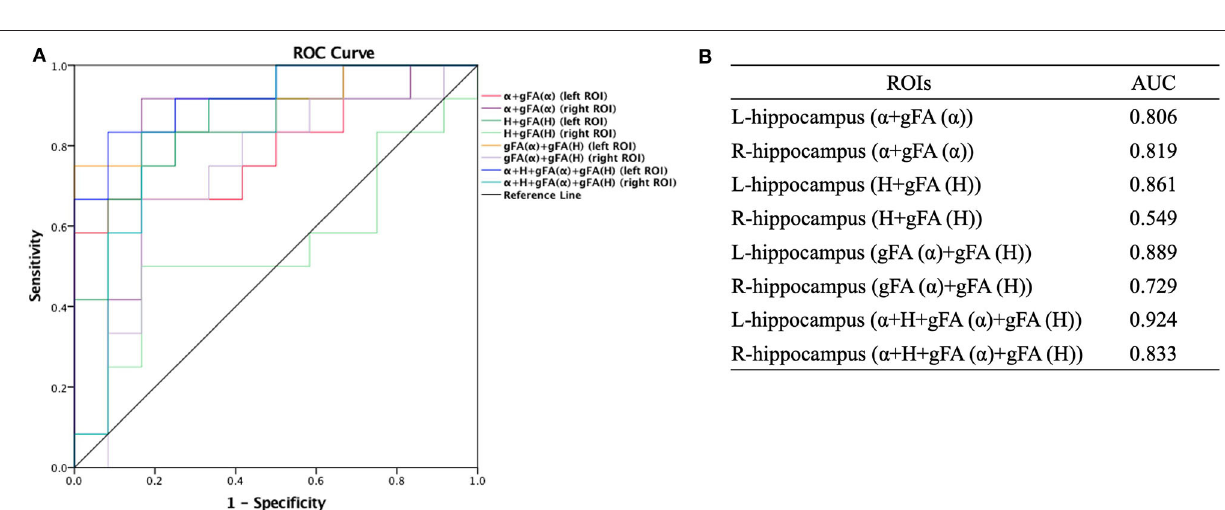
FIGURE 6 | Receiver-operating characteristic (ROC) curve was generated using the combination of gFA values and averaged values of α , H , and ADC for differentiating mild and moderate AD patients ( n = 12 in each group). (A,B) The combinations { α , gFA( α )} and { α , gFA( α ), H , gFA( H )} of the bilateral ROI and { H , gFA( H )} and {gF( α ) + gFA( H )} of the left ROI perfectly differentiate mild AD and moderate AD patients. The α combination { α , gFA( α )} and the H combination { H , gFA( H )} outperformed the directionally averaged α and H , respectively. ROC, receiver operating characteristic; ROI, region of interest; AUC, area under the curve; gFA, generalized fractional anisotropy; ADC, apparent diffusion coefficient; AD, Alzheimer’s